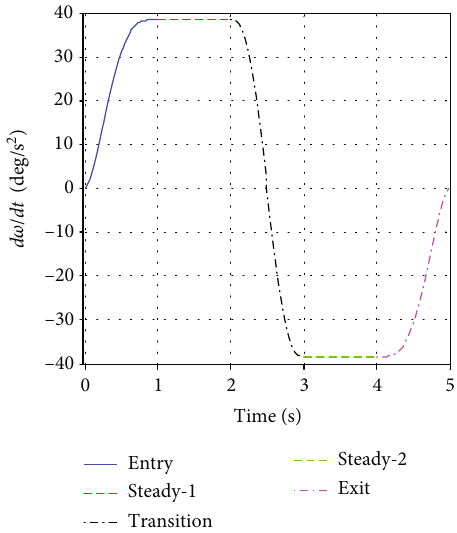
Figure 6: Trajectory of attitude angle satisfying boundary conditions.